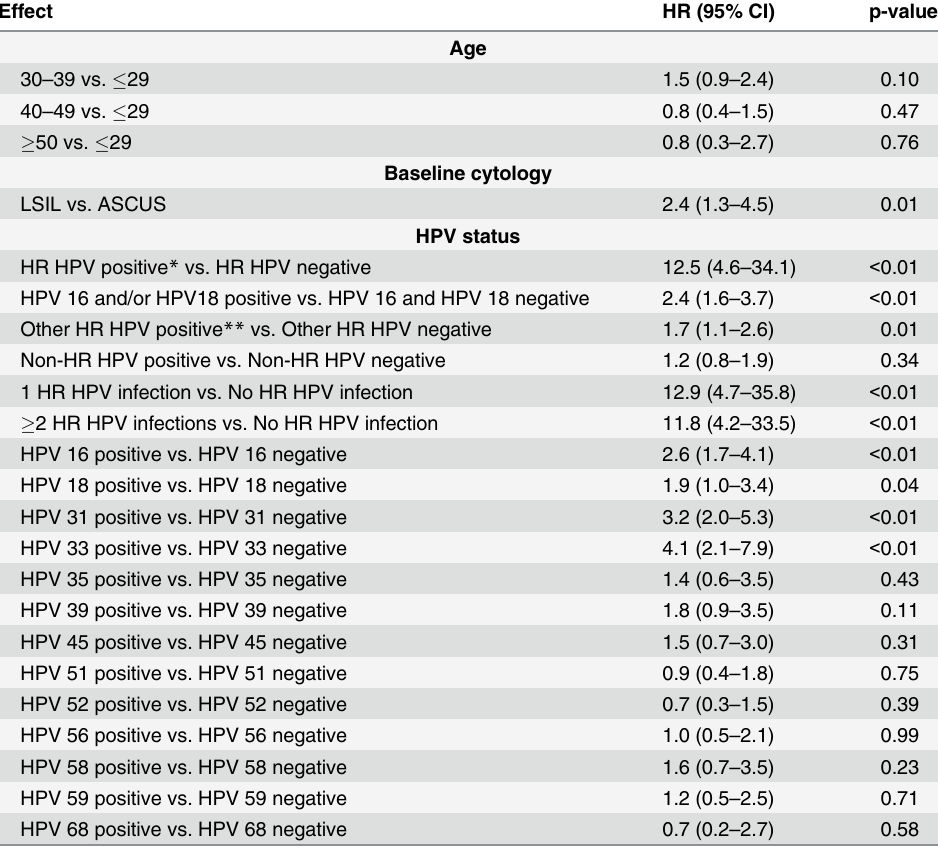
Table 2. Unadjusted association between baseline characteristics and